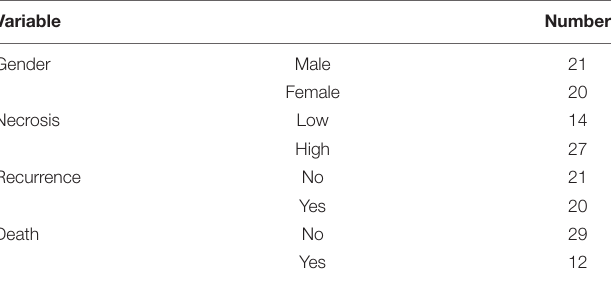
TABLE 1 | The clinical information of 41 OS patients from dataset GSE39058.